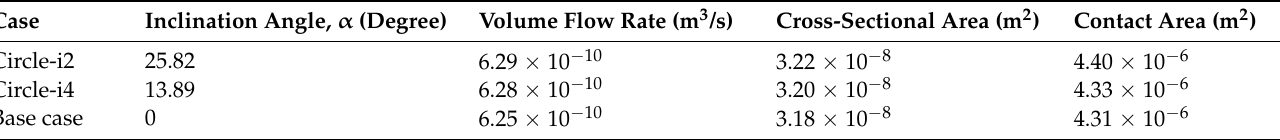
Table 11. Volume flow rate and contact area of slanted microchannels with circular shape.